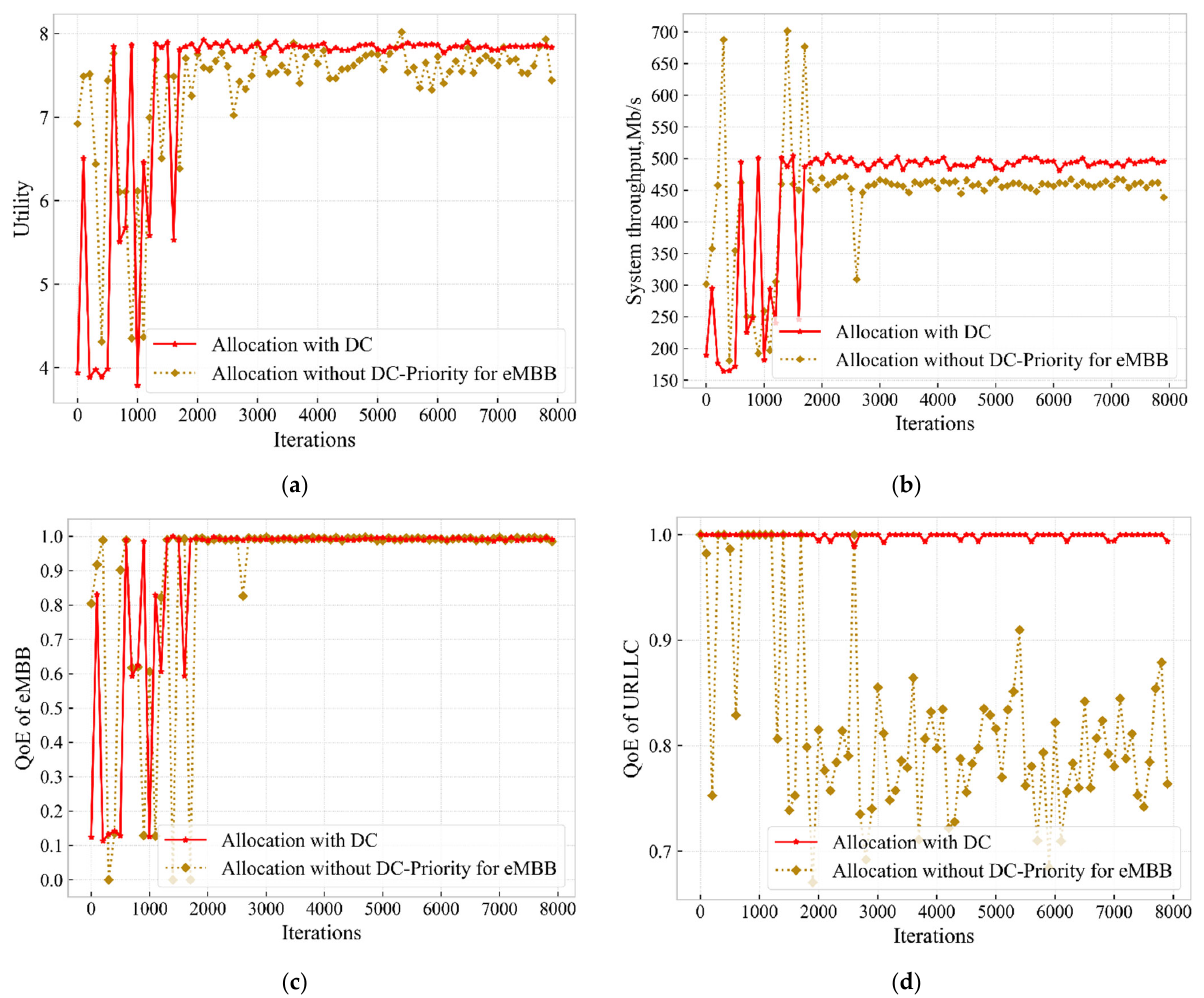
Figure 8. The comparison of optimization goals under the LSTM ‐ D3QN algorithm with and without dual connectivity assistance while there is priority for eMBB service. ( a ) The comparison of utility; ( b ) the comparison of system throughput; ( c ) the comparison of QoE of eMBB; ( d ) the comparison of QoE of URLLC.